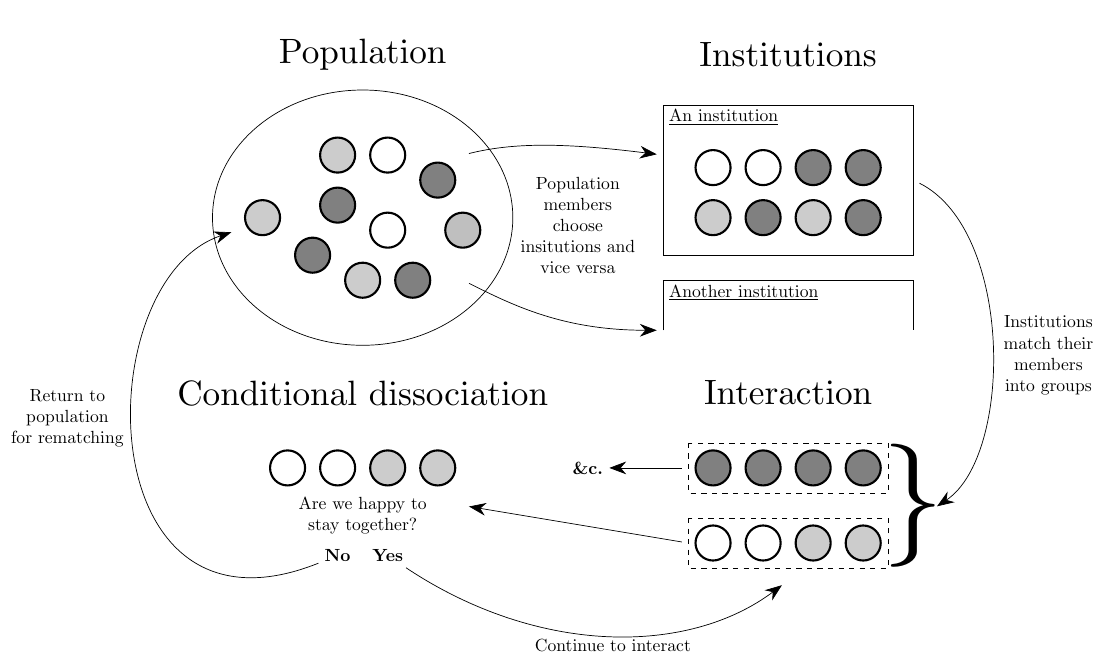
Figure 6. Assortativity in matching. From a population, individuals are matched into groups to interact (Section 3.3). This matching may be affected by the traits of the individuals (Section 3.2.1) and also by institutions at a societal level (Section 3.2.2). Individuals may be able to choose to join institutions (Section 3.2.3) and the institutions may have their own preferences over their